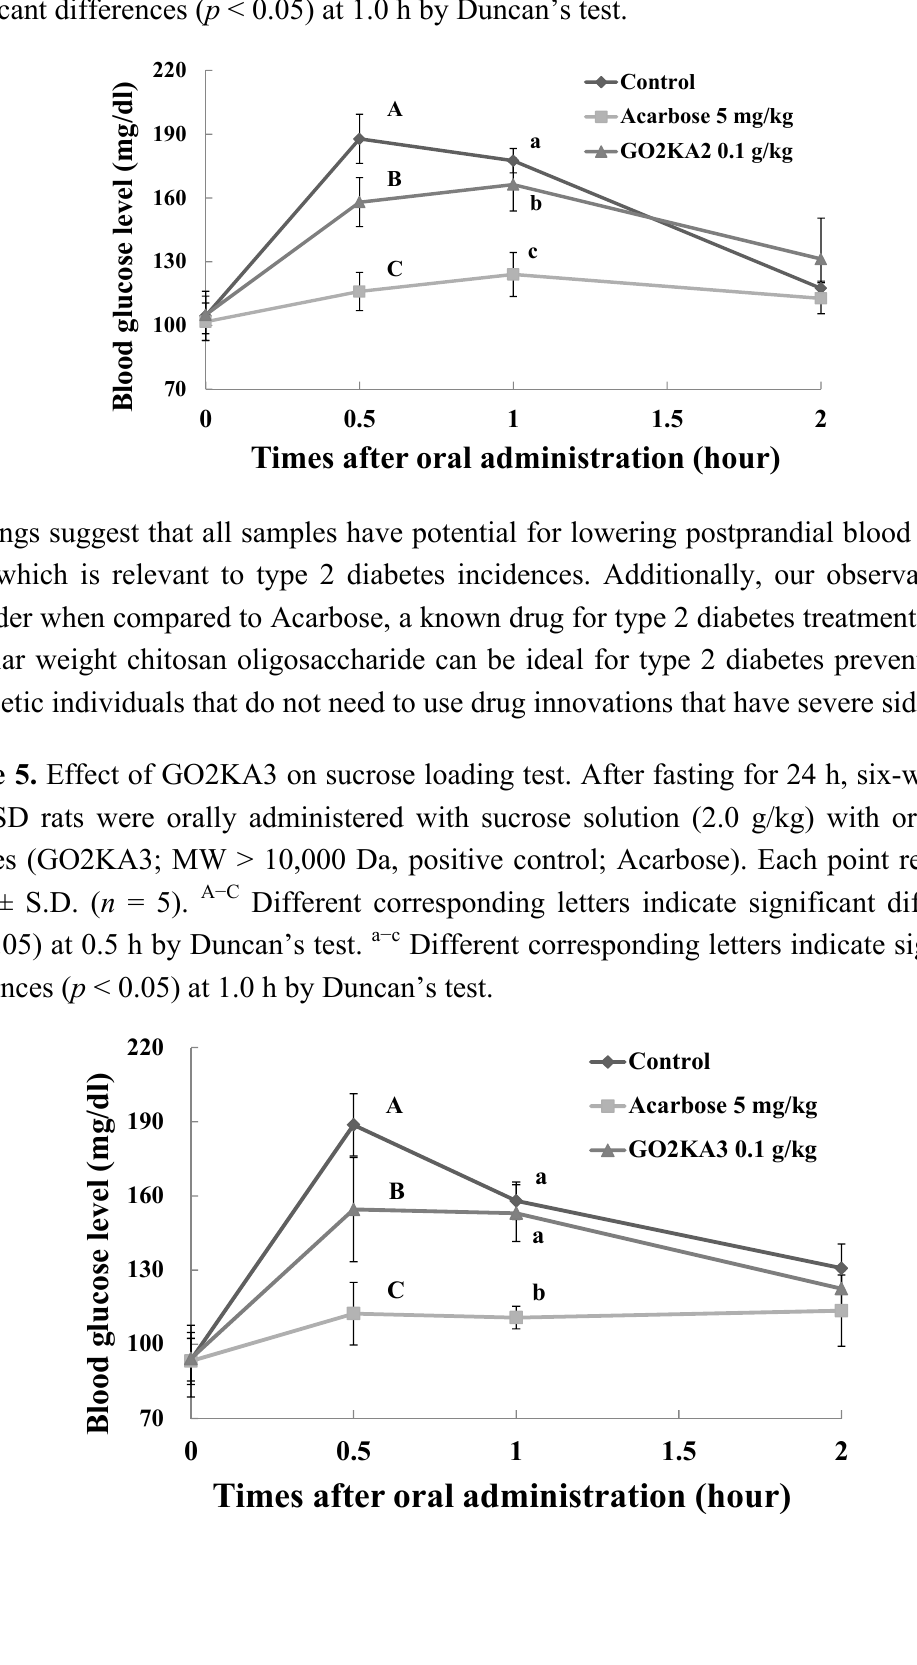
Figure 4. Effect of GO2KA2 on sucrose loading test. After fasting for 24 h, six-week-old, male SD rats were orally administered with sucrose solution (2.0 g/kg) with or without samples (GO2KA2; MW 1000–10,000 Da, positive control; Acarbose). Each point represents mean ± S.D. ( n = 5). A − C Different corresponding letters indicate significant differences ( p < 0.05) at 0.5 h by Duncan’s test. a − c Different corresponding letters indicate significant differences ( p < 0.05) at 1.0 h by Duncan’s test.